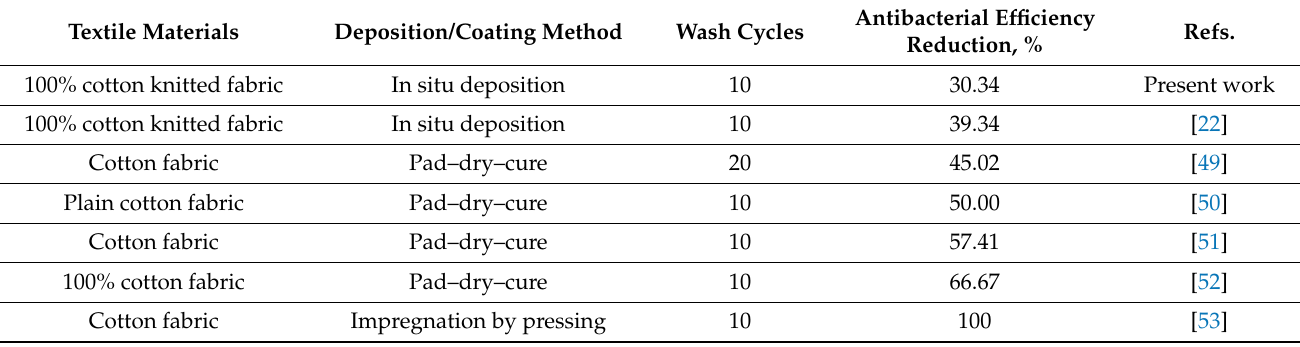
Table 10. Summary of the washing durability of antibacterial activity of AgNP-deposited/impregnated cotton fabric. Textile